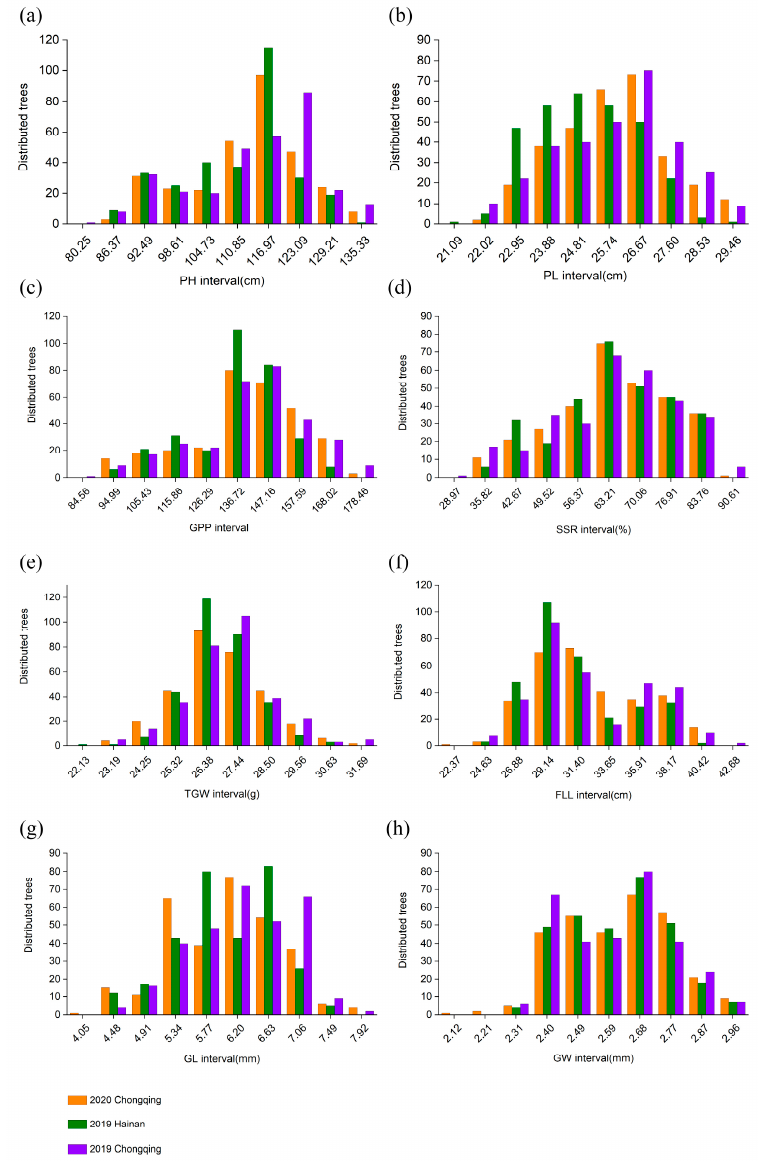
Figure 1. Multiyear and multisite phenotypic interval distribution of the eight agronomic traits in F 9 RIL S of Gr 89-1 × Shuhui 527: ( a ) PH interval, ( b ) PL interval, ( c ) GPP interval, ( d ) SSR interval, ( e ) TGW interval, ( f ) FLL interval, ( g ) GL interval, and ( h ) GW interval. ( e ) TGW interval, ( f ) FLL interval, ( g ) GL interval, and ( h ) GW In the RILs, there were 307 lines with GW greater than 2.26 mm (three-location aver-